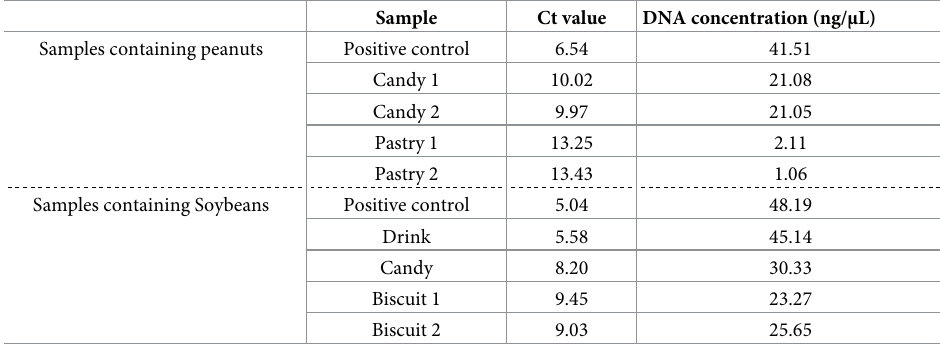
Table 2. The detected Ct values and DNA concentration values of commercially available products in this